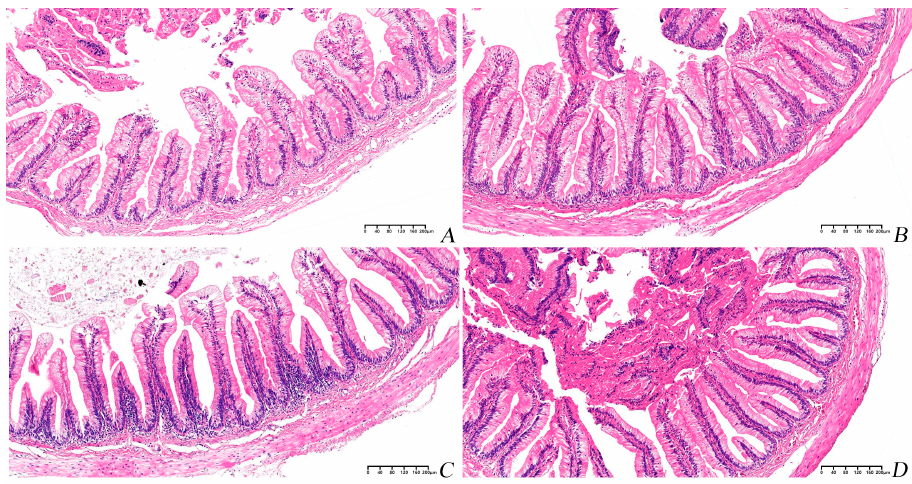
Figure 5. Histological sections of the intestines of Chinese soft − shelled turtle. Magnification times are 100×. ( A ) Turtle fed with Con diet. ( B ) Turtle fed with PBM5 diet. ( C ) Turtle fed with PBM10 diet. ( D ) Turtle fed with PBM15 diet. The scale bar was 200 μ m.